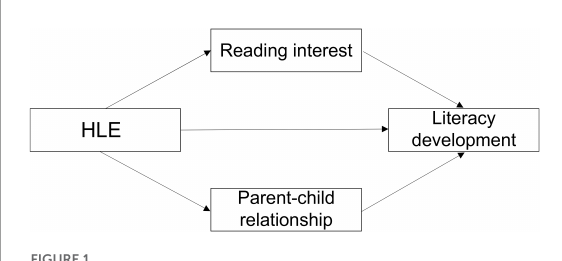
FIGURE1 A hypothetical model of children with hearing loss for mediating the interactions between HLE and literacy development by reading interest and parent-child